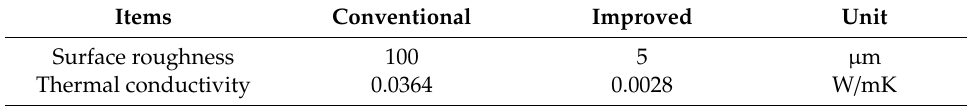
Table 1. Comparison of characteristics of vacuum insulation material with surface quality improvement.